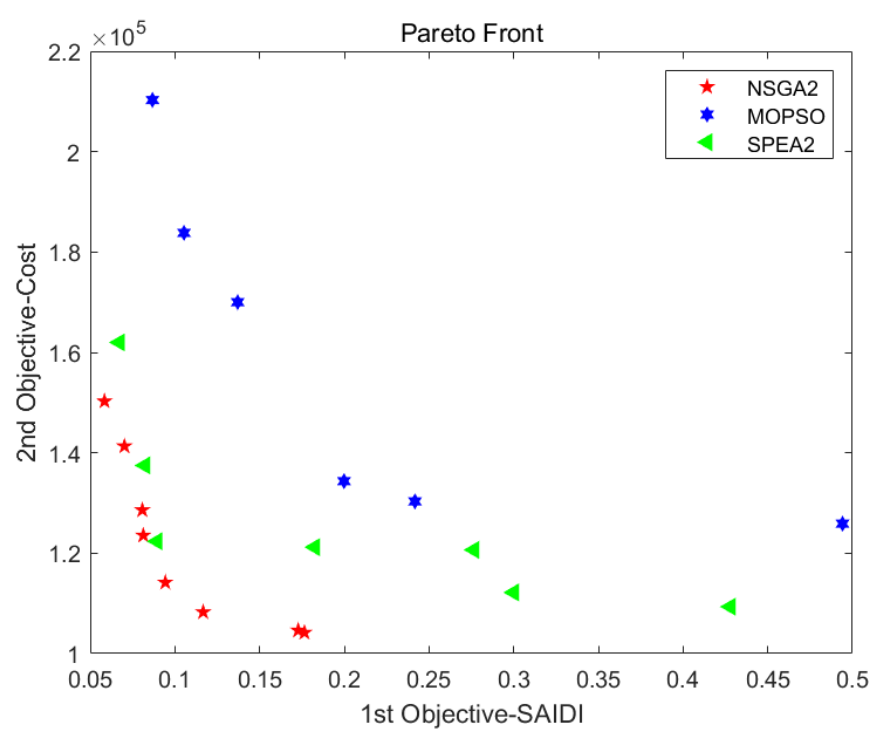
Figure 8. Pareto front results of three multi-objective algorithms.